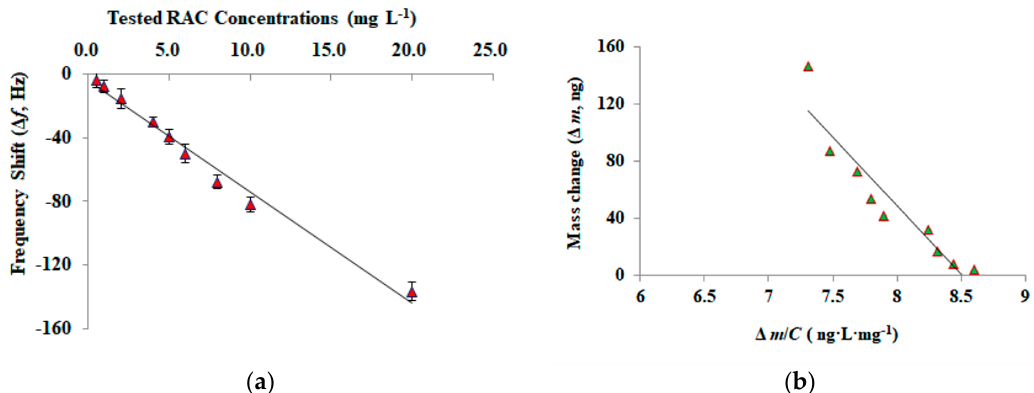
Figure 5. Linear curves of the frequency shift value ( Δ f ) for the tested RAC concentrations ( a ) and Langmuir analysis ( b ).